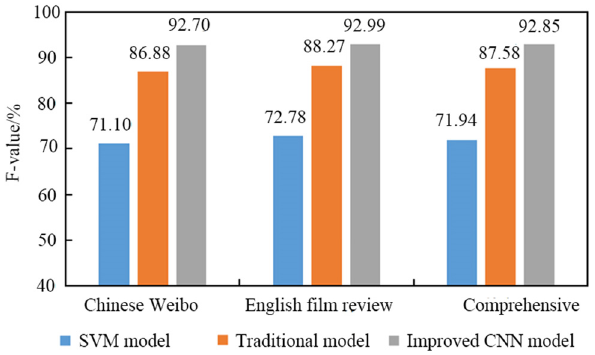
Figure 8: The F - value of three classi fi cation models for text emotional tendency classi fi